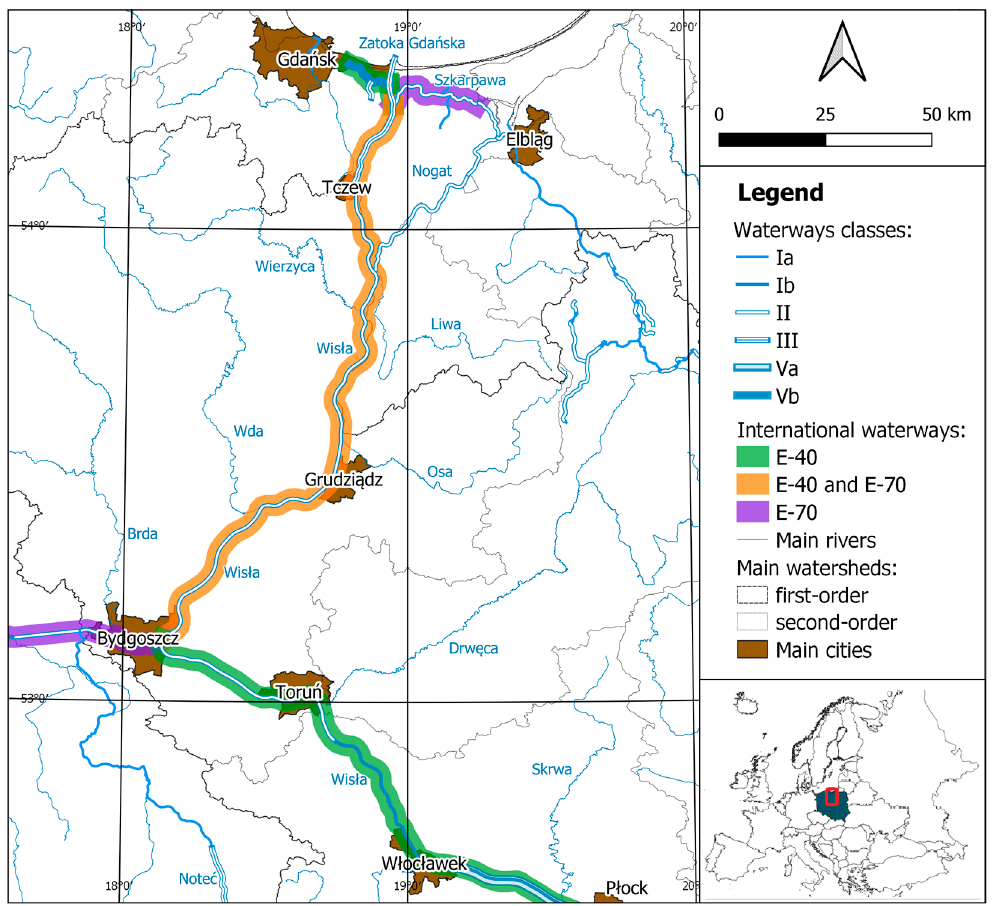
Figure 1. The analyzed section of the Vistula River from the Włocławek barrage to the estuary to the Gdansk Bay, divided into inland waterway classes. Source: own study based on [13–15].